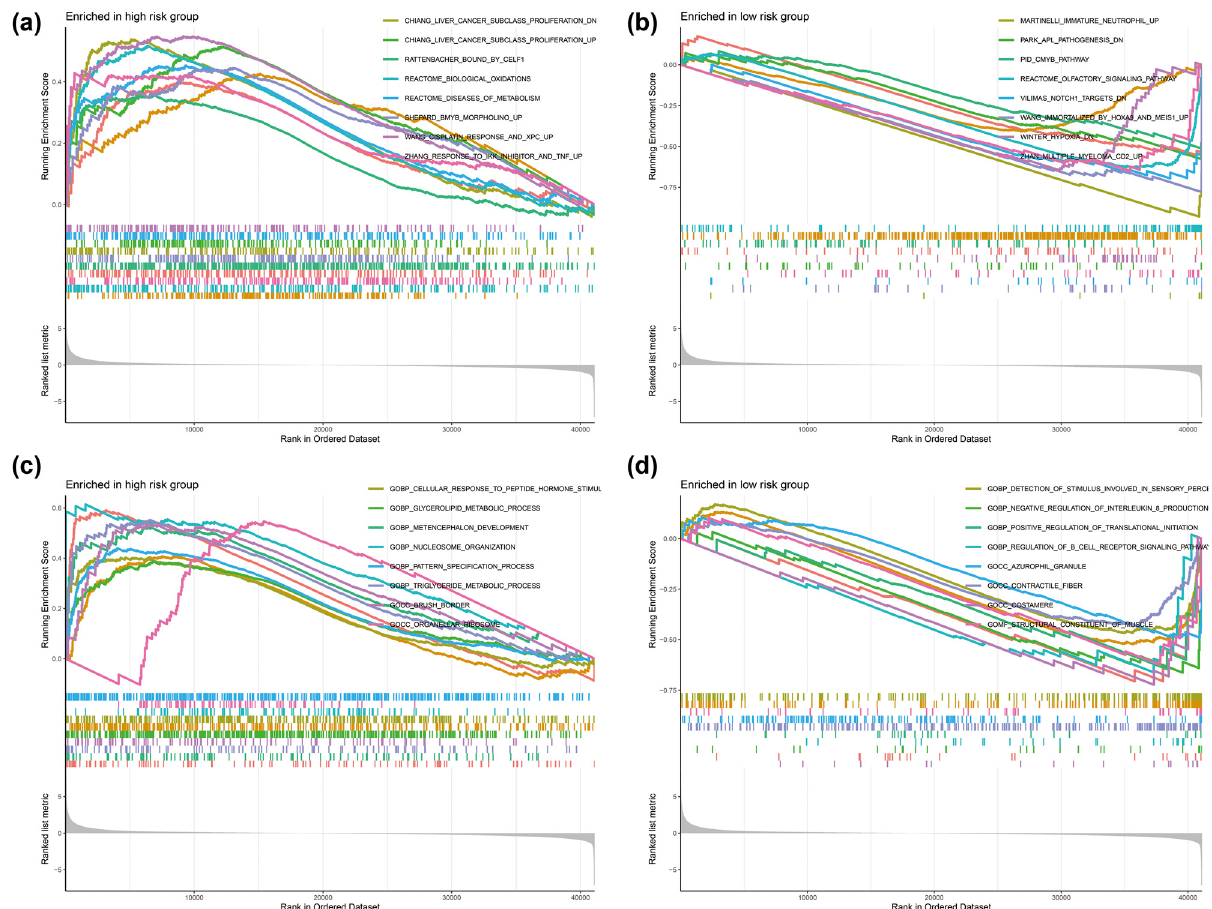
Figure 7: GSEA results between low - and high - risk score phenotypes in GC: ( a ) GSEA results in high - risk score group using the c2 reference gene set; ( b ) GSEA results in low - risk score group using the c2 reference gene set; ( c ) GSEA results in high - risk score group using the c5 reference gene set; and ( d ) GSEA results in low - risk score group using the c5 reference gene